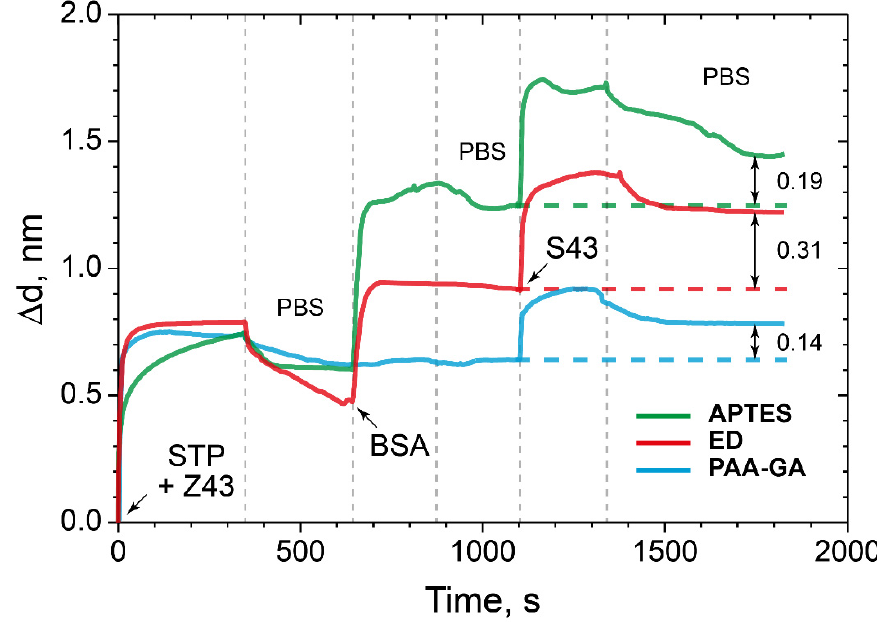
Figure 9. The change in the adlayer thickness upon binding of STP-biotinylated oligosensor with specific oligotarget: the PC surface modified with ED (red), APTES (green), and PAA and GA (blue).